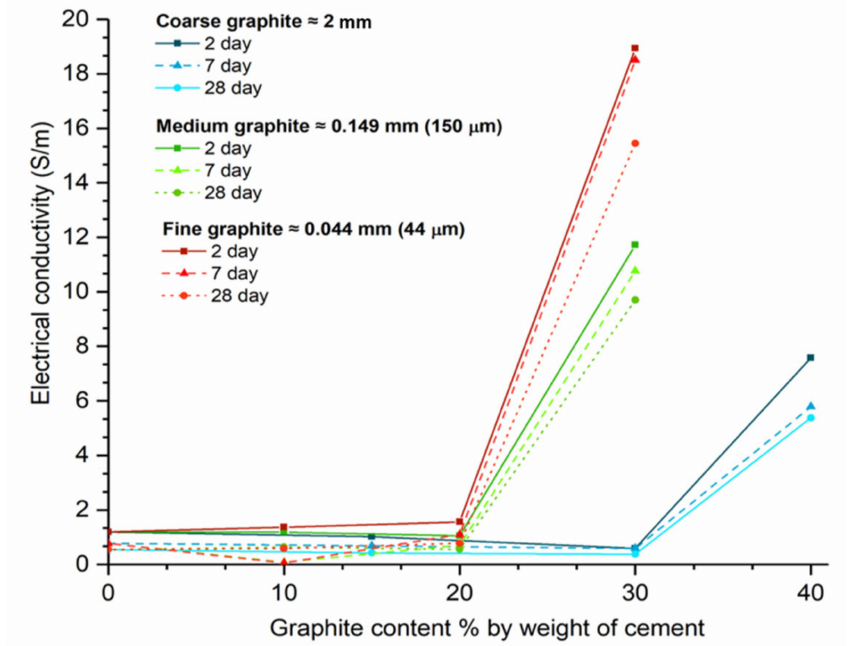
Figure 10. E ff ect of graphite fineness and dosage on the electrical conductivity of CEMI pastes ( w / c =